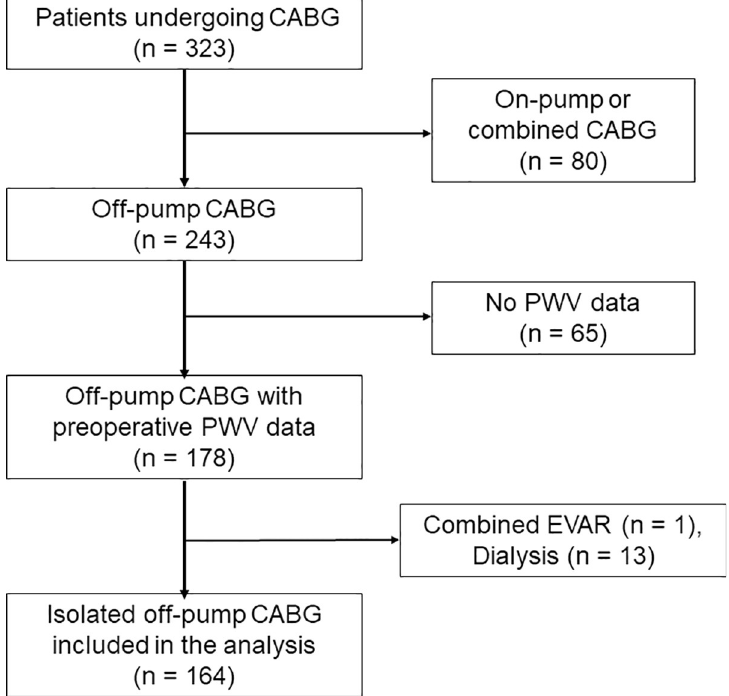
Fig 1. Patient selection. CABG, coronary artery bypass grafting; EVAR, endovascular abdominal aortic repair; PWV, pulse wave velocity.